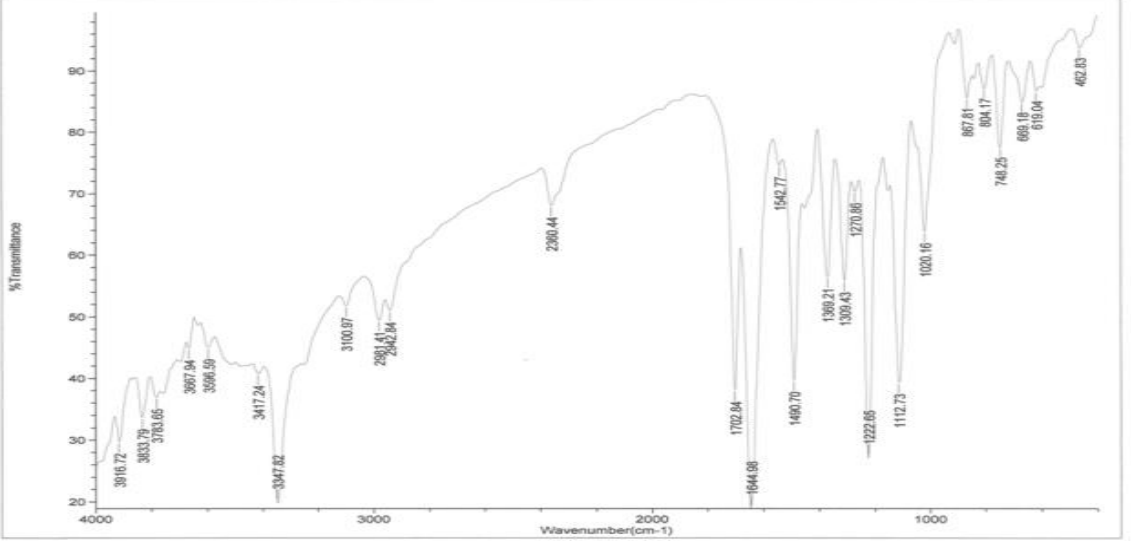
Figure 6. FTIR spectrum of isradipine